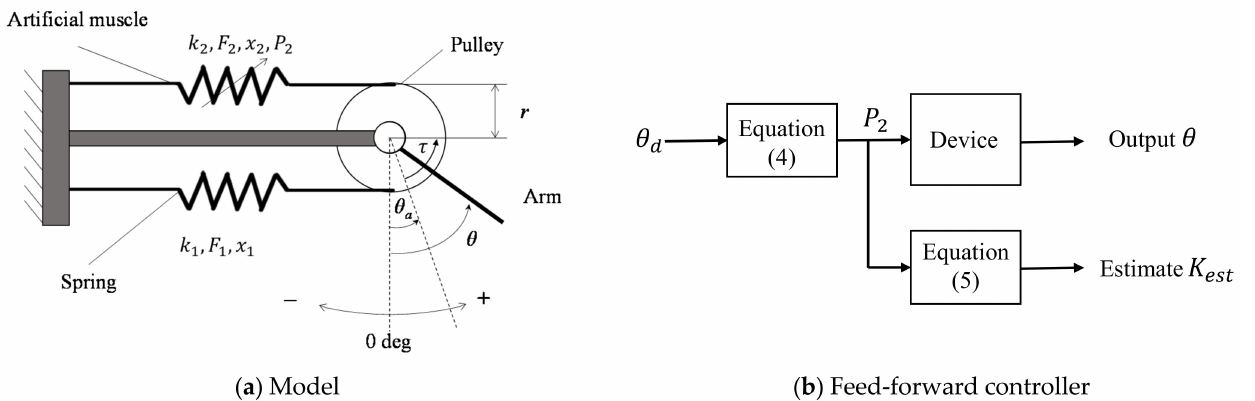
Figure 3. Model and block diagram of the one-sided spring antagonized joint